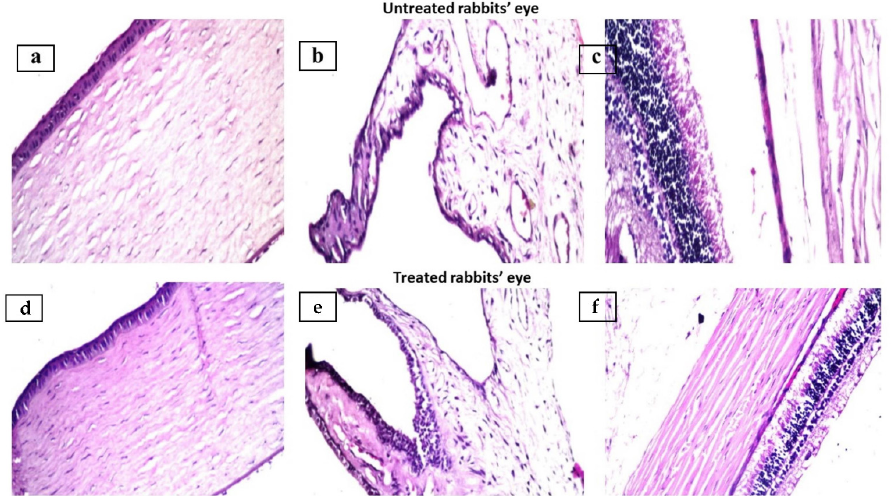
Figure 9. Photomicrographs showing histopathological sections of normal untreated and treated rabbits’ eyes (SCM8–1 formulation) stained with hematoxylin and eosin. The photomicrographs show histological structure of the ( a , d ) cornea, ( b , e ) iris, ( c , f ) retina, choroid and sclera (×40).